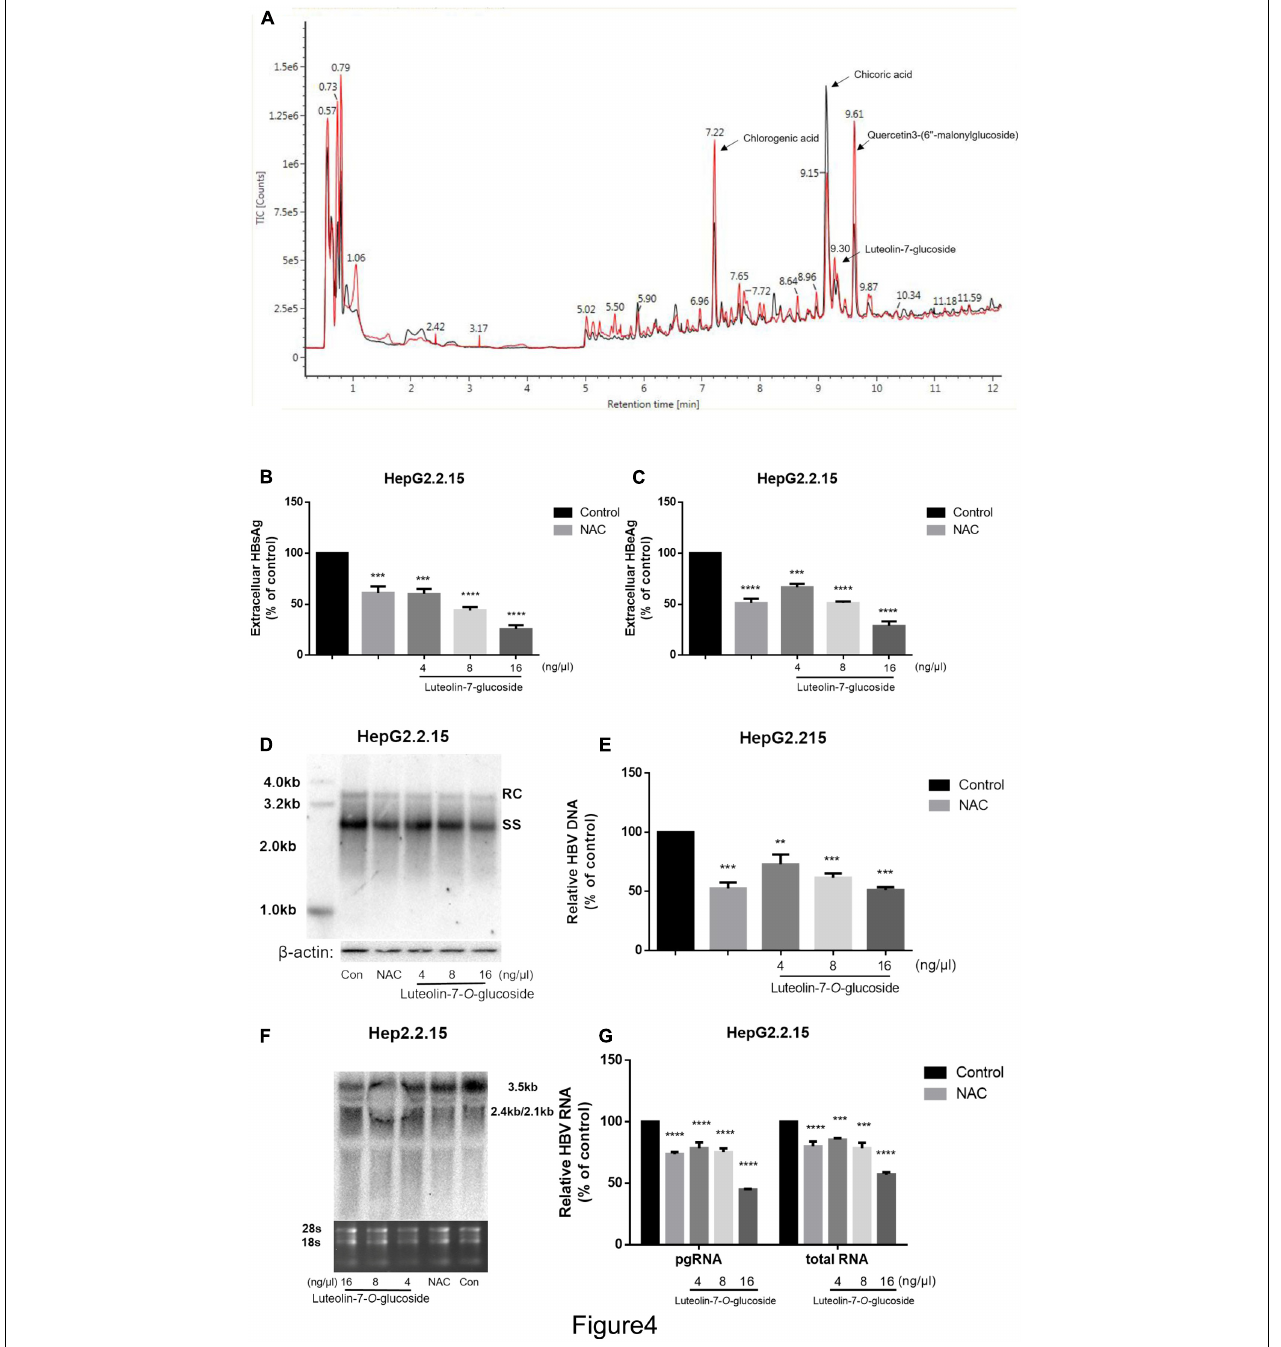
FIGURE 4 | The identification of the main effective components of lettuce extracts and confirmation of its inhibitory effects on HBV. The components of lettuce extracts were determined by UPLC-IMS-QTOF/MS and analyzed by differential metabolomics approach. The red line was different with black line (except for the start because of chromatographic co-effluents) (A) . Based on online databases, literature and standards, and the collision cross section values, chlorogenic acid, chicoric acid, luteolin-7- O -glucoside and quercetin 3-(6 (cid:48)(cid:48) -malonylglucoside) were identified. The luteolin-7- O -glucoside suppresses HBV viral antigen in a dose-dependent manner in HepG2.2.15 cell line and 10 mM NAC was used as a positive control (B,C) . HBsAg and HBeAg levels in culture supernatants were measured using an electrochemical illuminescent immunoassay. HBV replication intermediates were extracted and detected by Southern blot hybridization (D) or quantified using fluorescence quantitative PCR (E) . Viral RNAs were examined by Northern blot (F) or quantified using fluorescence quantitative PCR (G) . All values are expressed as percentages relative to untreated control. RC, relaxed circular DNA; SS, single-stranded DNA. β -actin served as the DNA loading control and 18S/28S RNAs served as the RNA loading control. Statistical significance was calculated using student’s t -test. Ns, not significant, ∗ P < 0.05, ∗∗ P < 0.005, ∗∗∗ P < 0.0005, ∗∗∗∗ P < 0.0001.